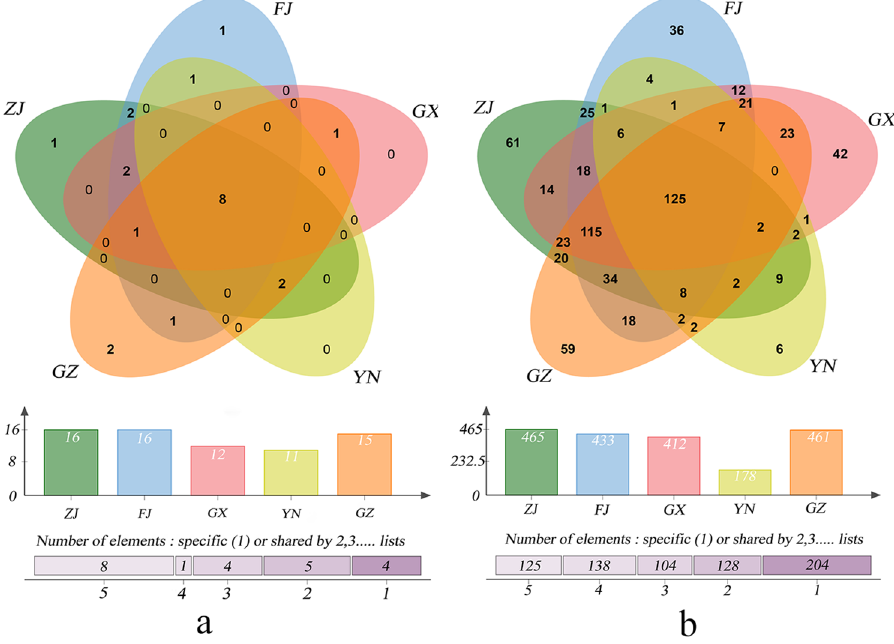
Fig 2. The phylum levels (A) and genus levels (B) of species composition of five planting bases samples.